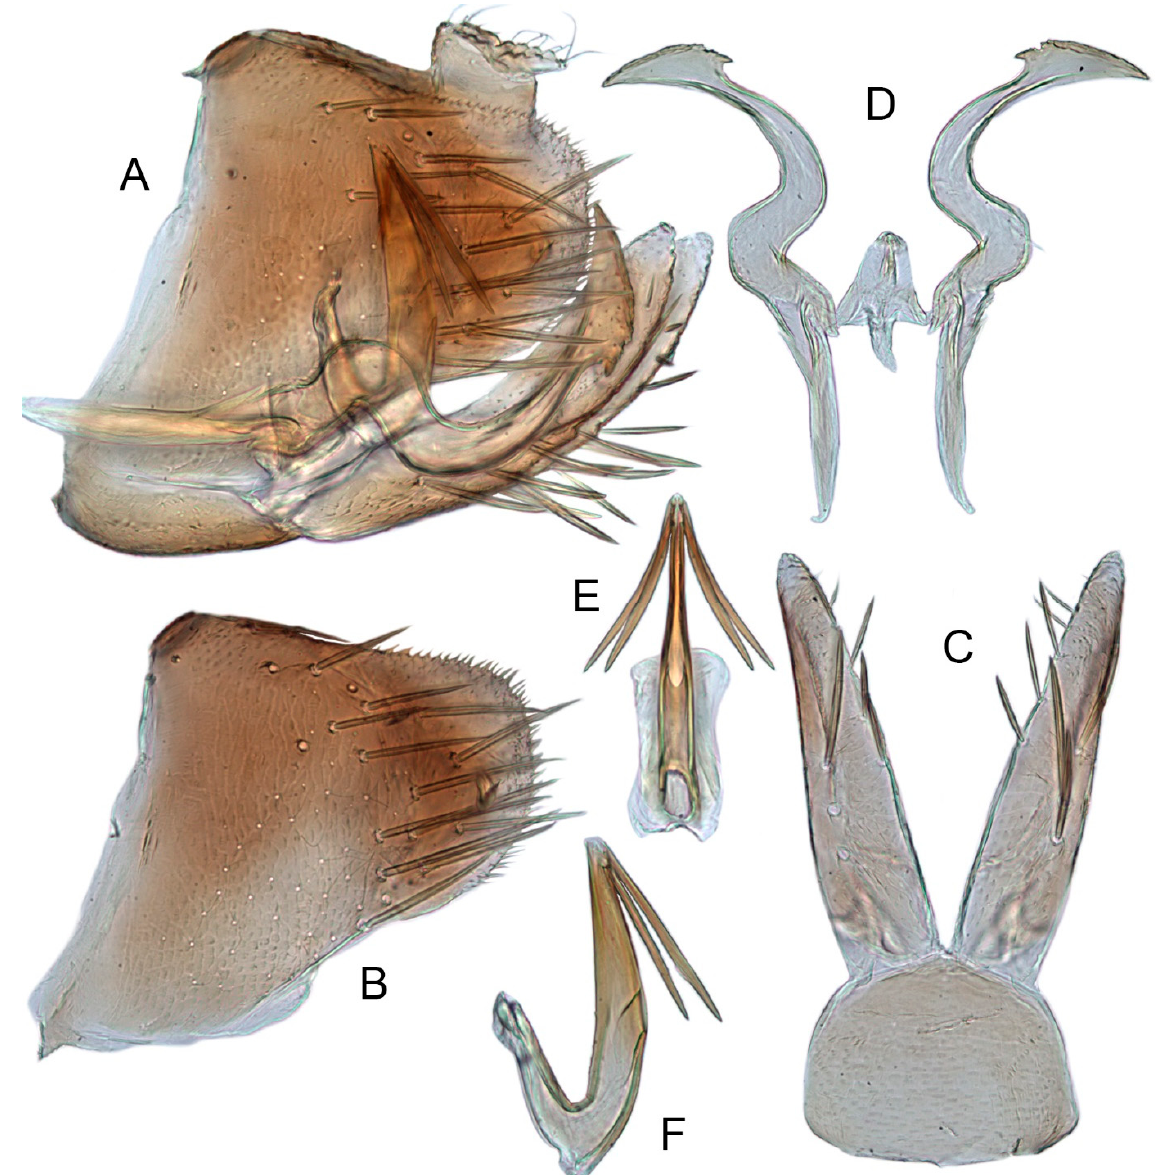
Figure 14. Xestocephalus tenusis , sp. nov. ( A ) Male genital capsule, lateral view; ( B ) pygofer lobe; ( C ) subgenital plates and valve, ventral view; ( D ) style and connective, ventral view; ( E ) aedeagus, posterior view; ( F ) aedeagus, lateral view.